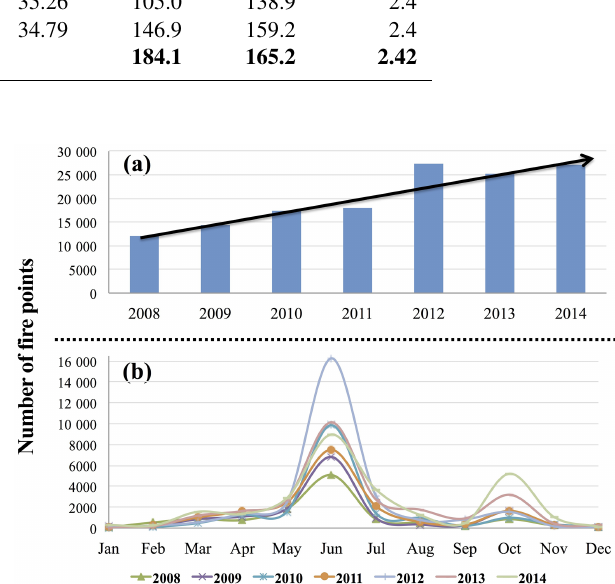
Figure 2. The (a) yearly and (b) monthly CFB observed by MODIS in the research domain during the year of 2008 to